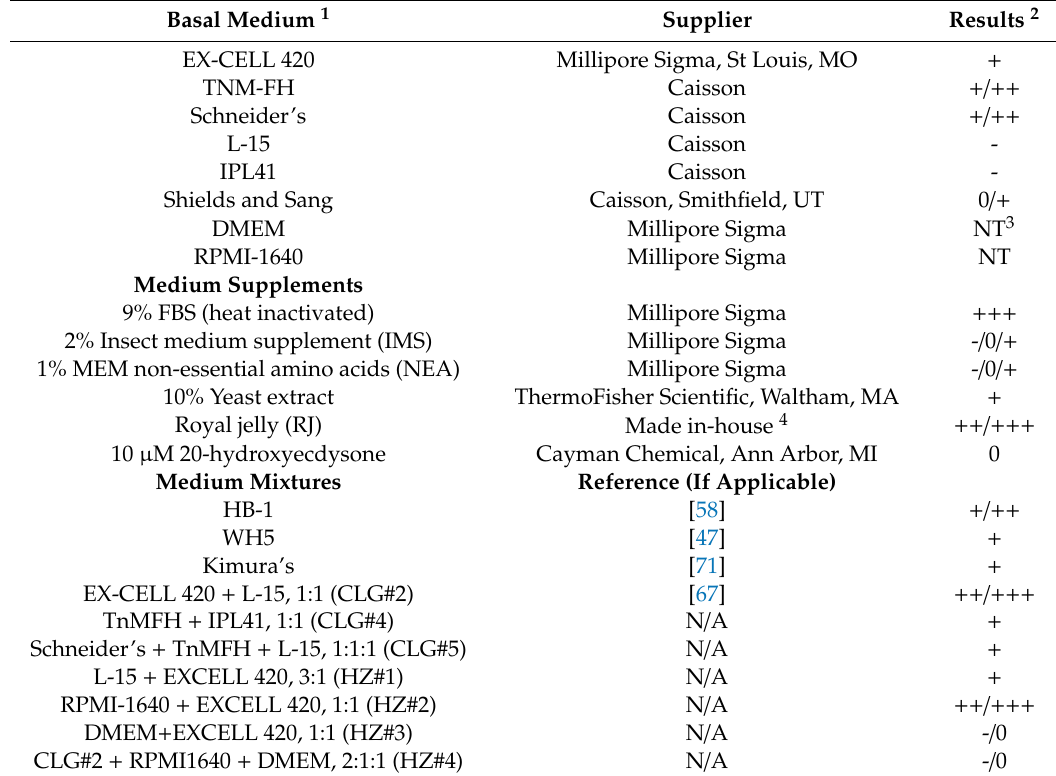
Table 3. Examples of basal media, nutrient supplements and media combinations tested in honey bee cell culture initiations at